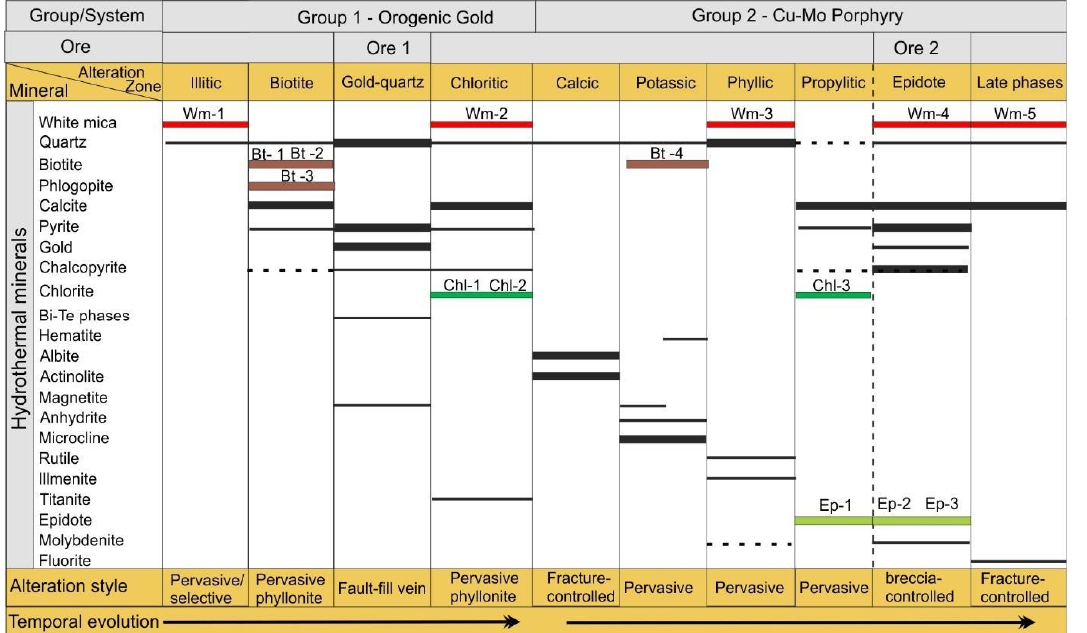
Figure 13. Schematic paragenetic chart proposed for the Paraíba deposit, showing the two groups of hydrothermal alterations. It was based on drill core logging, petrographic description, and reflectance and SisuCHEMA data. Group 1 shows characteristics of an orogenic gold event. Group 2 is associated with a magmatic-hydrothermal event, with porphyry characteristics. Minerals present as common or minor phases are represented by solid and dashed lines, respectively, and the relative abundance is proportional to the thickness of the bars. Types of chlorite (Chl – 1, – 2, – 3) and white mica (Wm – 1 to – 5) as presented in the text.